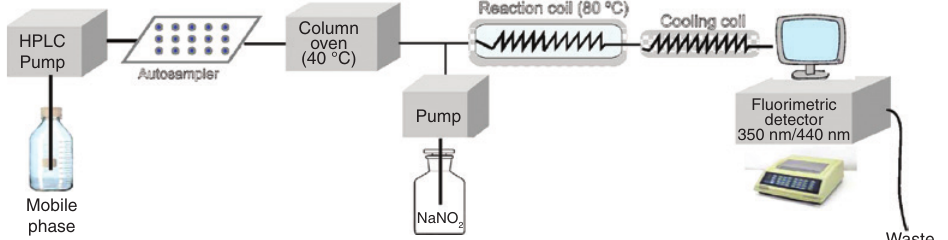
Figure 3: Schematic diagram of a post-column oxidation coupled to a fluorimetric HPLC system to analyze 6R-BH4, 6S-BH4 and several pteridines in tissues, and the dialysate collected in vivo . Adapted from